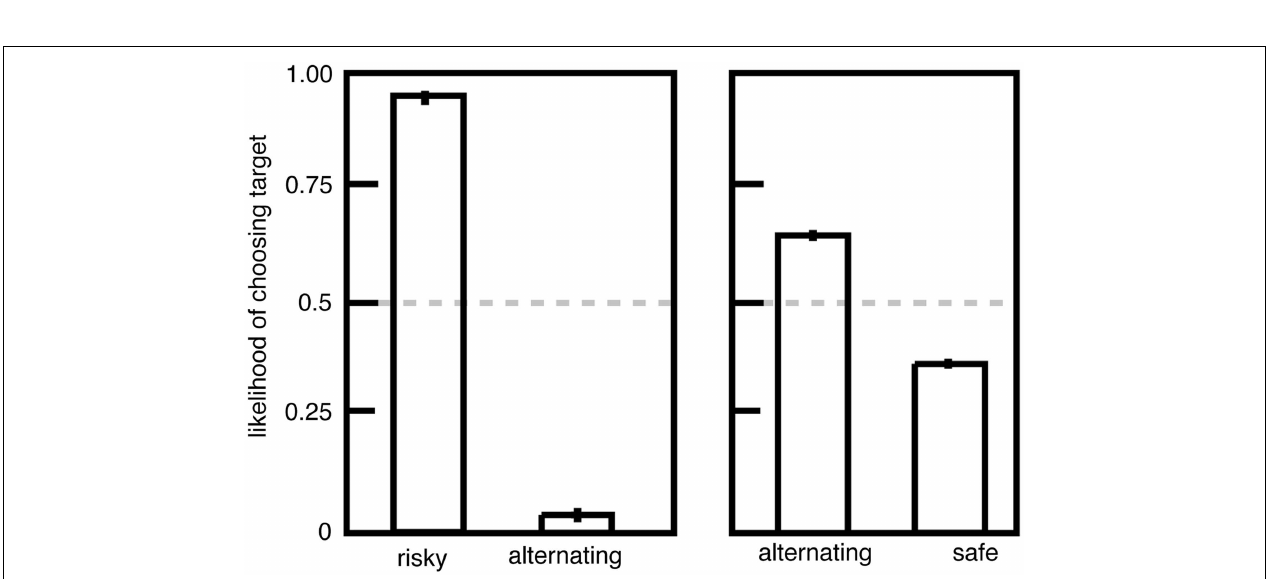
FIGURE 1 | Schematic of standard utility curve argument for risk-aversion (left) and risk-seeking (right). Decision-makers are assumed to have a non-linear shaped utility curve.When evaluating a gamble, decision-makers will utilize the computed expected utility rather than the